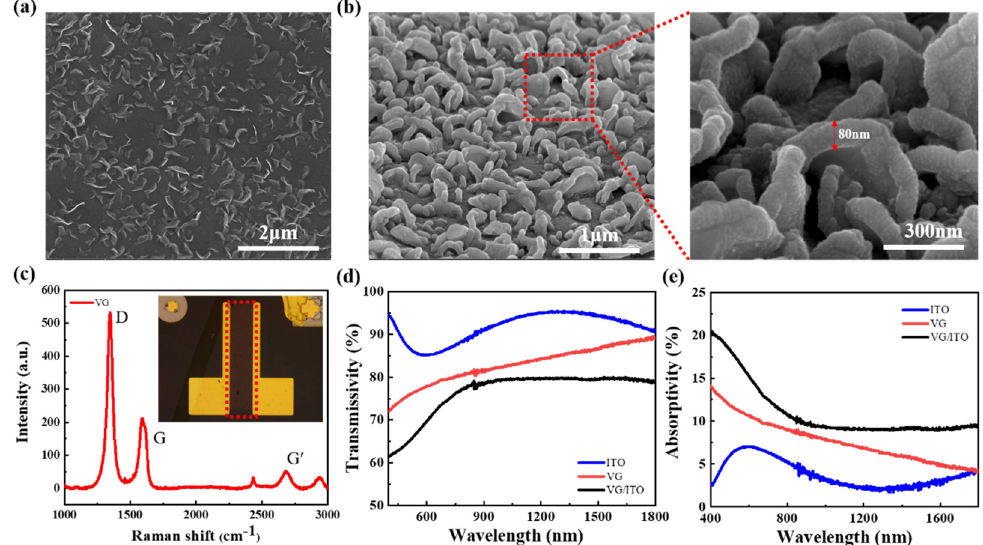
Figure 2. Characterization of VG and VG/ITO. ( a ) SEM images of VG on glass. ( b ) SEM images of VG/ITO on glass. ( c ) Raman spectroscopy of VG. The inset in ( c ) shows the optical image of the VG/ITO composite structure photodetector. ( d ) The transmittance of three films (ITO, VG, and VG/ITO) measured by UV − NIR absorption spectrophotometer. ( e ) The absorptivity of three films (ITO, VG, and VG/ITO).